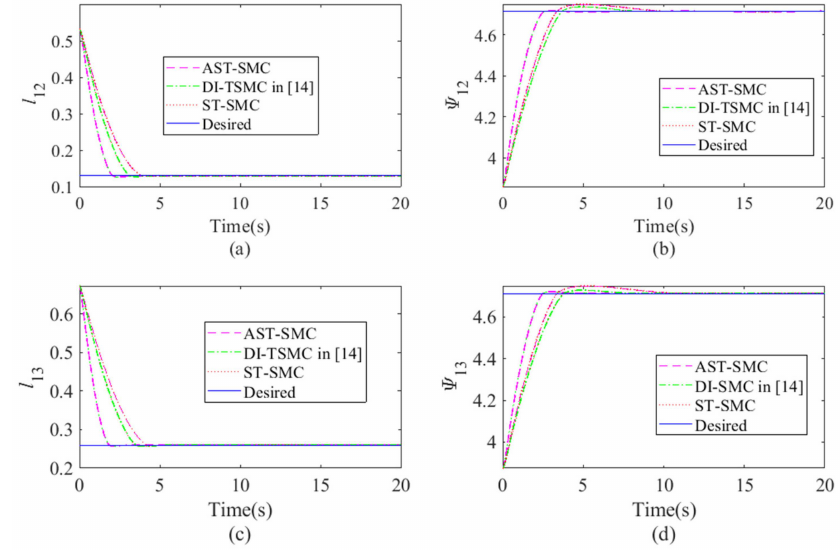
Figure 4. Comparisons of the state variables by di ff erent control methods. ( a ) l 12 , ( b ) Ψ 12 , ( c ) l 13 , ( d ) Ψ 13